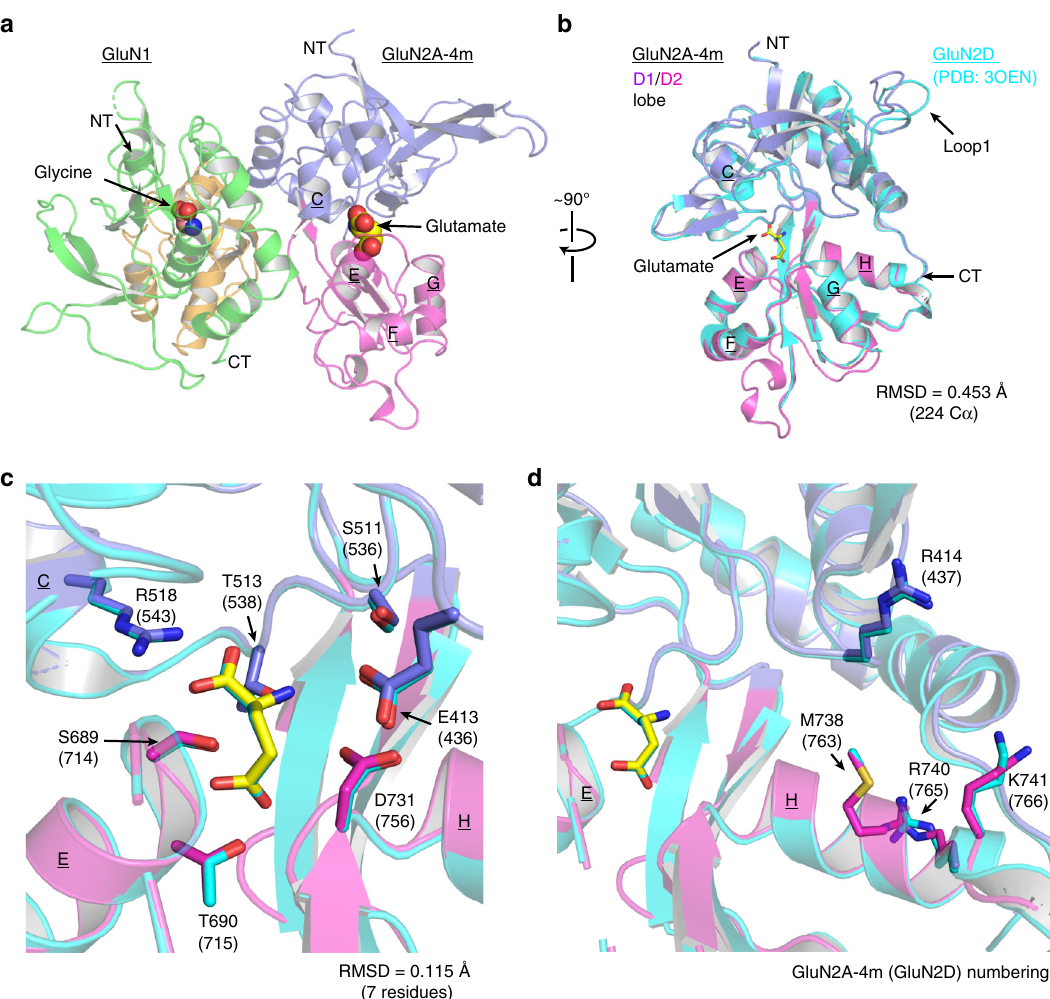
Fig. 4 Crystal structure of GluN1 – GluN2A-4m LBD and comparison with GluN2D LBD. a Crystal structure of the GluN1 – GluN2A-4m LBD heterodimer in complex with glycine (orange sphere) and L -glutamate (yellow sphere). Helices are labeled with underlined letters and the color coding is in accordance to Fig. 1. b Structures of the GluN2A-4m LBD and the GluN2D LBD (PDB: 3OEN) can be superposed with one another at an RMSD of 0.45 Å over 224 C α positions. c Comparison of the L -glutamate-binding sites of GluN2D and GluN2A-4m shows the similar mode of ligand-receptor interactions. Residue numbering shown for GluN2A-4m and GluN2D (in brackets). d Mutated residues in GluN2A-4m overlap well with the equivalent residues in GluN2D with minor differences in side chain